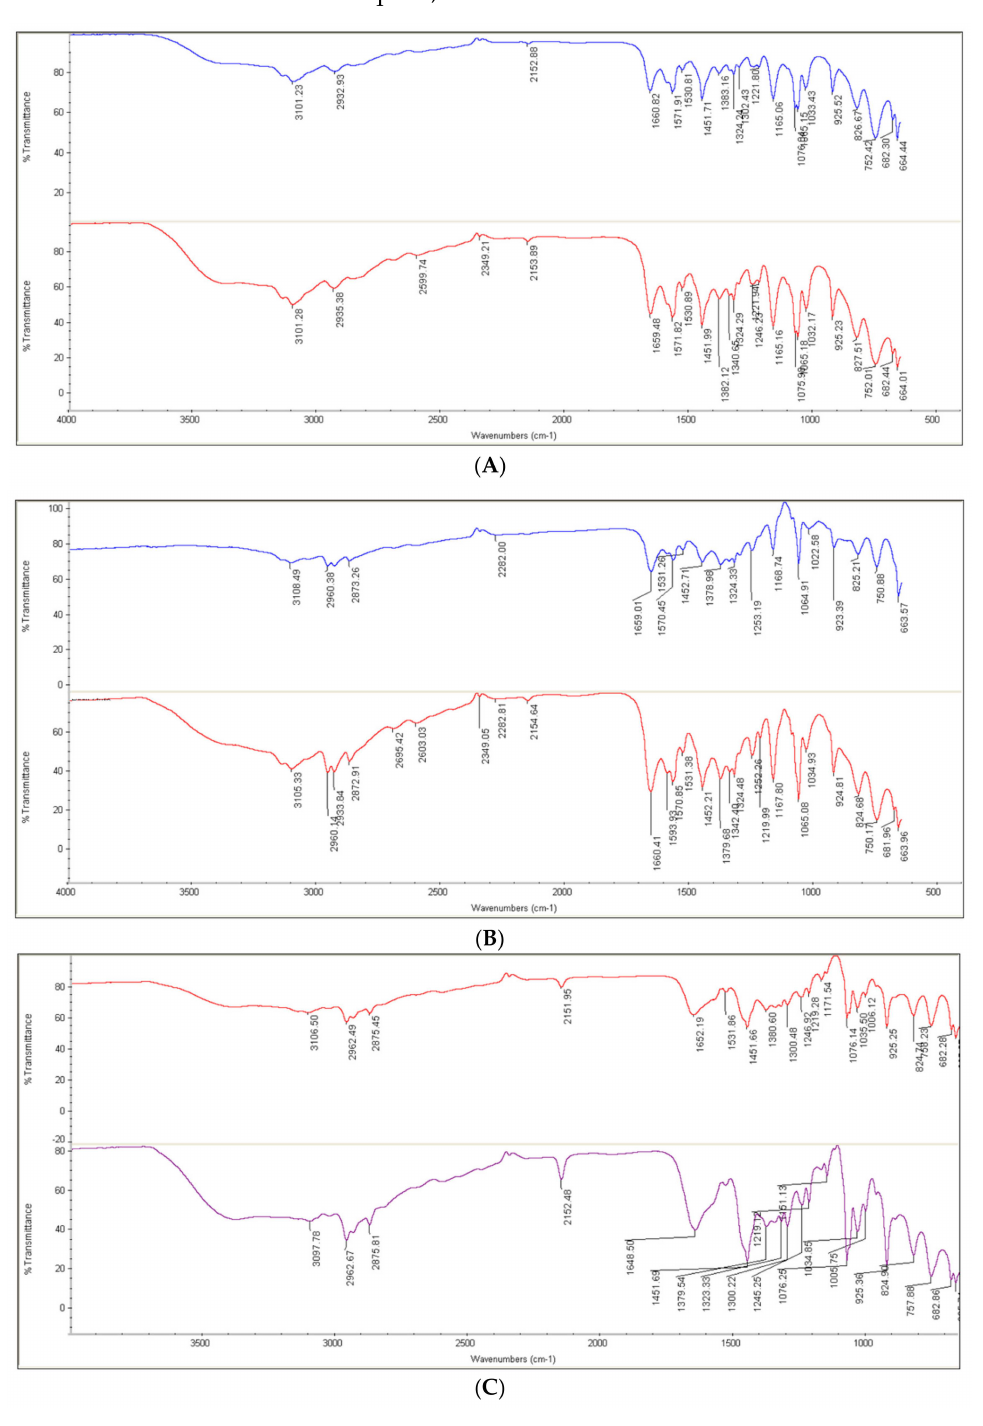
Figure 9. Fourier Transform Infrared Spectroscopy (ATR-FTIR) spectrum for BBMImIM ( A ), BMImIM ( B ) and BMPyrIM ( C ) as a pure and adsorbed on the mild steel surface after immer- sion for 24